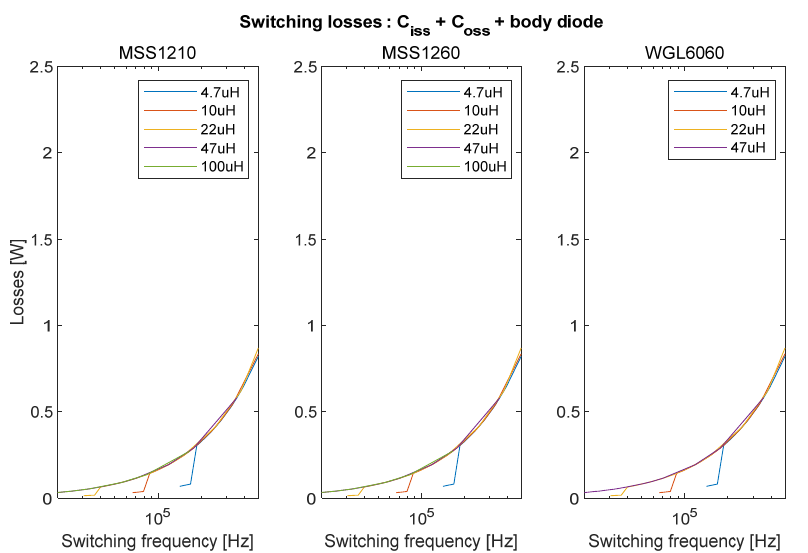
Figure 20. Active device switching losses for a 50 W–30 V to 20 V converter with respect to the main inductor value and the switching frequency.